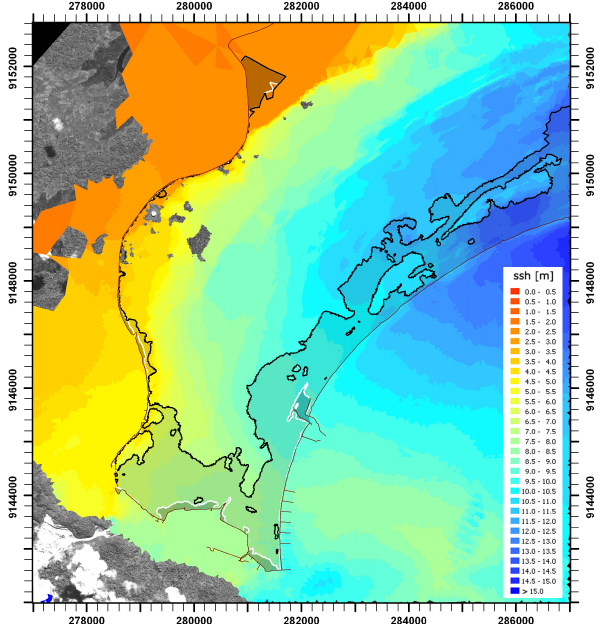
Fig. 12. Worst case scenarios for Cilacap. Coloured area: sea surface heights of scenario 055 10 mw9.0, black line: inunda- tion of scenario 055 12 mw8.5, white line: inundation of scenario 055 12 mw8.0, thin line: coast.